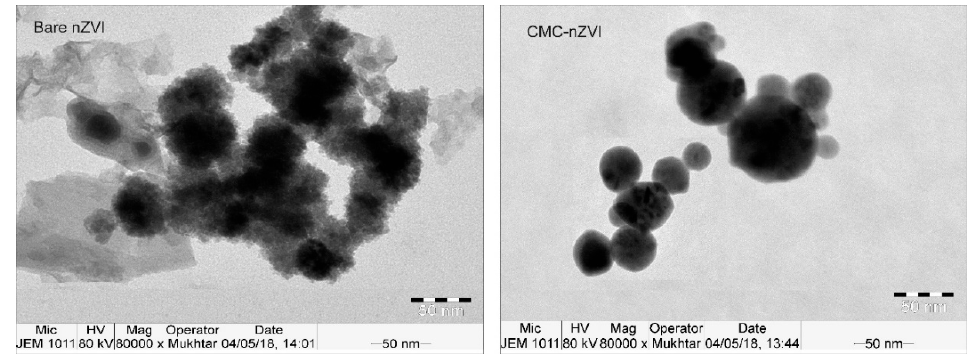
Figure 2. Effect of CMC polymer stabilizer on the Brunauer, Emmett and Teller (BET) Figure 2. E ff ect of CMC polymer stabilizer on the Brunauer, Emmett and Teller (BET) adsorption / adsorption/desorption isotherms of nZVI particles. desorption isotherms of nZVI particles.